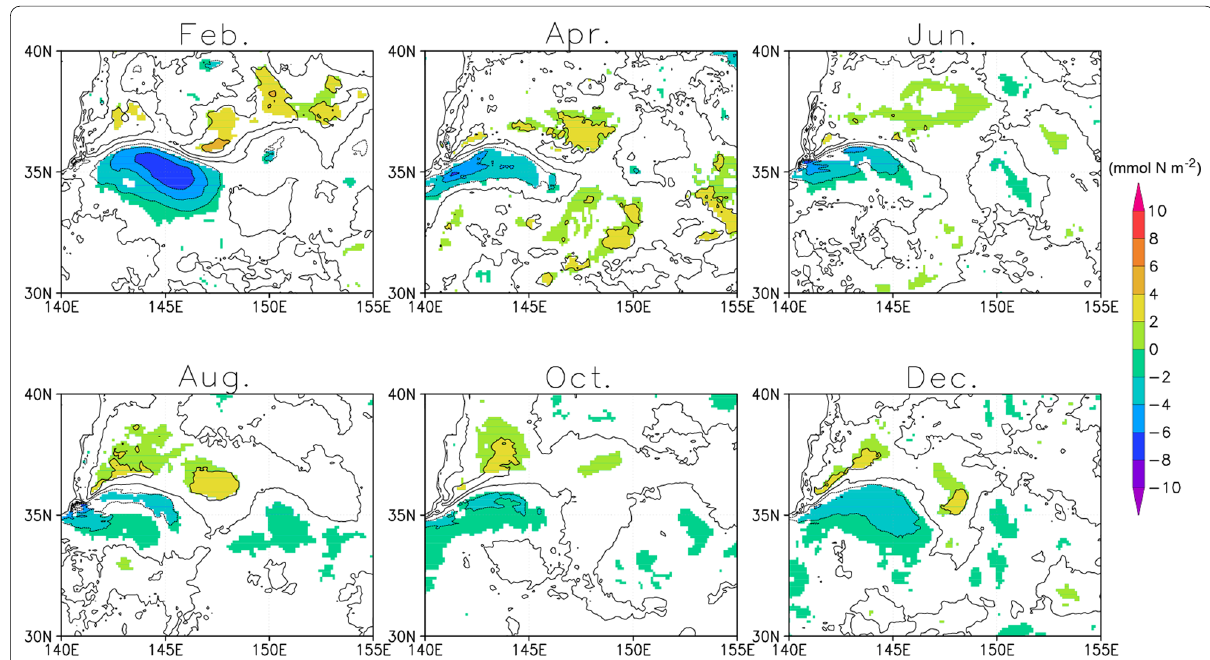
Fig. 6 Composites of phytoplankton concentration anomalies integrated over the upper 100 m. The contour intervals are 2 mmol N m − 2 . Anomalies significant at the 95% confidence level by a two-tailed t test are